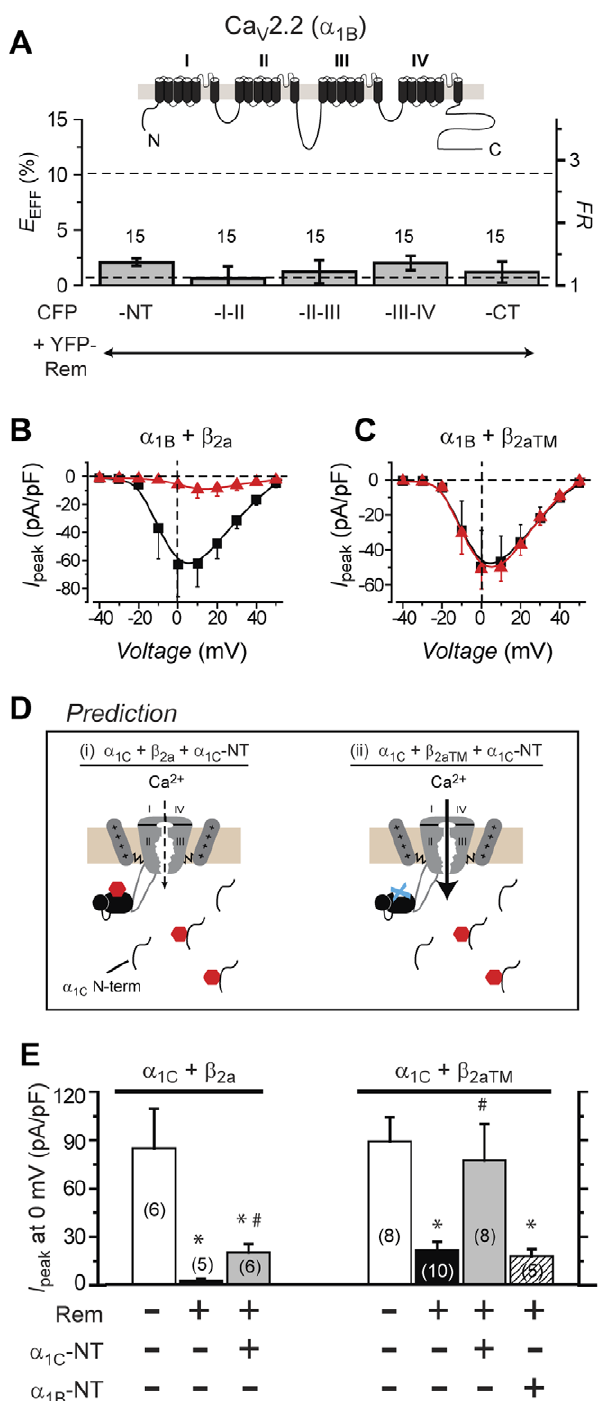
Figure 4. Rem interaction with a 1C N-terminus mediates b - binding-independent inhibition. (A) Top , topography of Ca V 2.2 a 1B subunit. Bottom , interaction of Ca V 2.2 a 1B intracellular domains with YFP-Rem probed using FRET. Dotted lines represent FRET data from YFP-Rem + CFP- a 1C NT and YFP-Rem + CFP, respectively. (B, C) Population I peak - V relationships for wild type ( a 1B + b 2a ) and mutant ( a 1B + b 2aTM ) Ca V 2.2 channels, respectively, in the absence ( & , n =5 for wild type channels, and n =9 for mutant channels) or presence (red m , n =5 for wild type channels, and n =10 for mutant channels) of Rem. Data are means 6 S.E.M. (D) Schematic showing rationale and predictions for a 1C N-terminus over-expression experiments. (E) Histogram showing